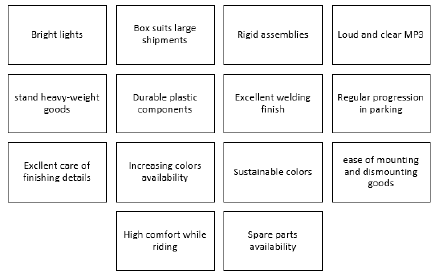
Figure 2. Collecting the sticky notes